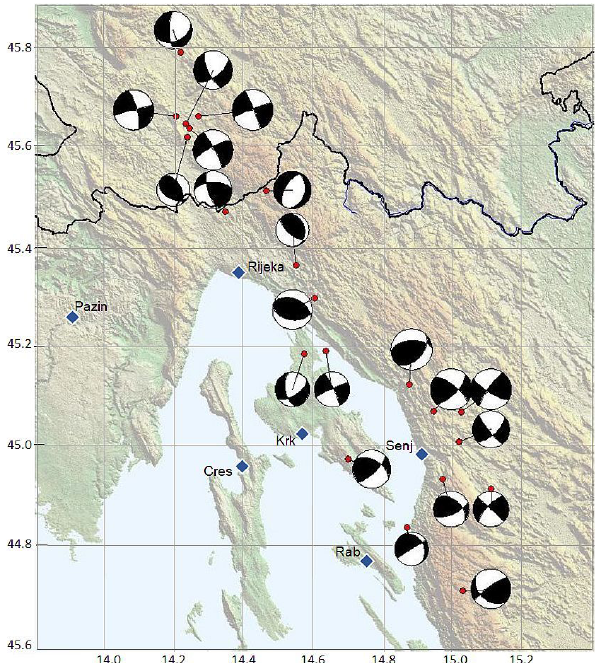
Figure 3. Focal mechanisms for regional earthquakes ( M w ≥ 3 . 0) from the Croatian source mechanism database. Stereographic pro- jection of the lower focal hemisphere was used. When prepar- ing figure, Copernicus land dataset was used (© European Union, Copernicus Land Monitoring Service 2017, European Environment Agency – EEA).